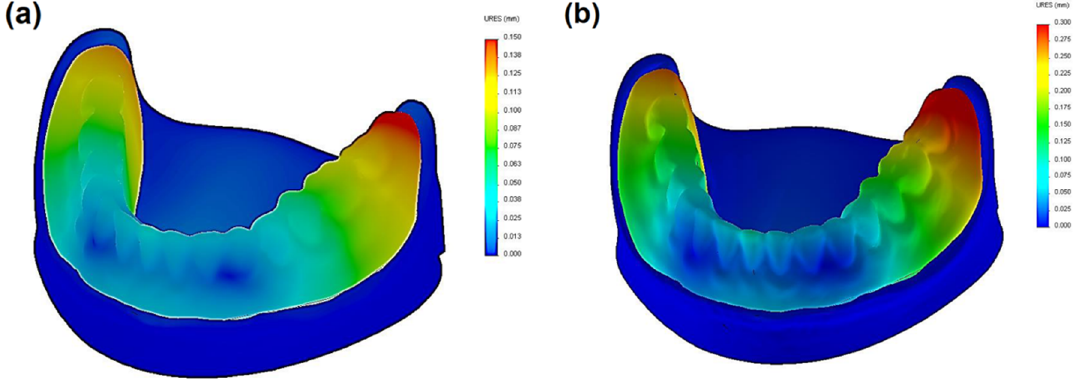
Figure 6. Distribution of displacements in an overdenture when an incisor is loaded with a vertical force of 50 N: ( a ) system I and ( b ) system II.